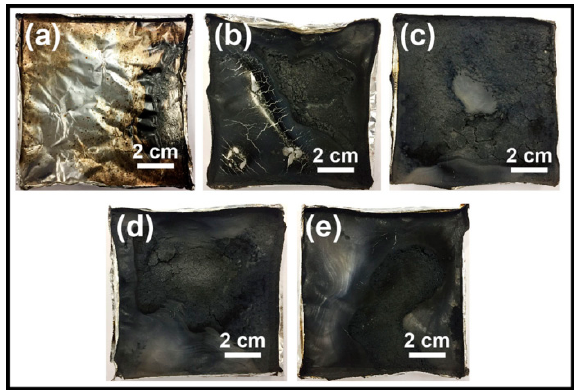
Figure 7. Digital photos of char residues after cone calorimeter tests: ( a ) pure PLA, ( b ) g-C 3 N 4 -2%, ( c ) Co / P-C 3 N 4 -2%, ( d ) Co / P-C 3 N 4 -5%, and ( e ) Co / P-C 3 N 4 -10%.